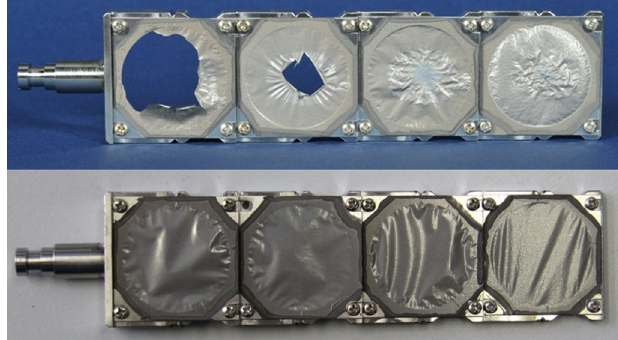
FIG. 4. Foil stripper before (bottom) and after (top) high current operation. For the second foil (top, from the right) 11 kJ of beam energy were deposited without any observed influence on the beam parameters